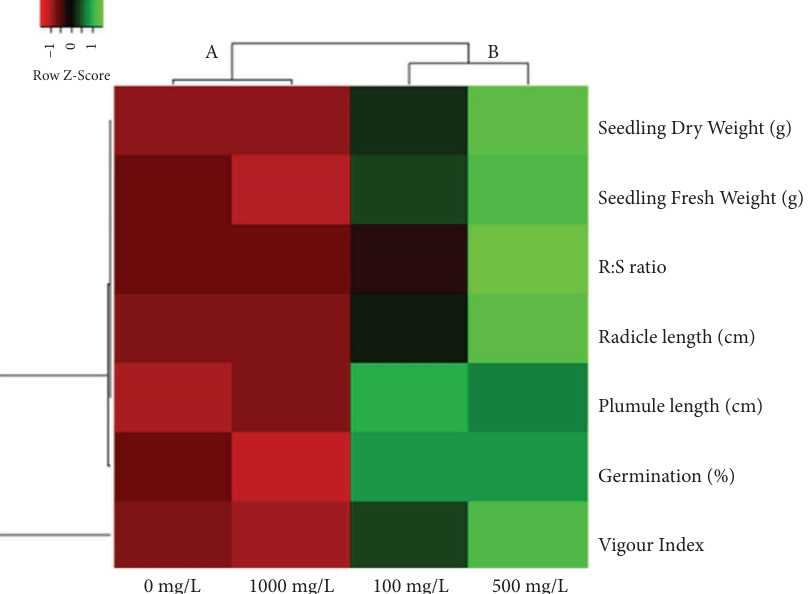
Figure 8: Heatmap clusters on the efect of diferent concentrations of ZnO NPs on seedling growth parameters. Mean values refer to colors from minimum displayed in red to maximum represented with